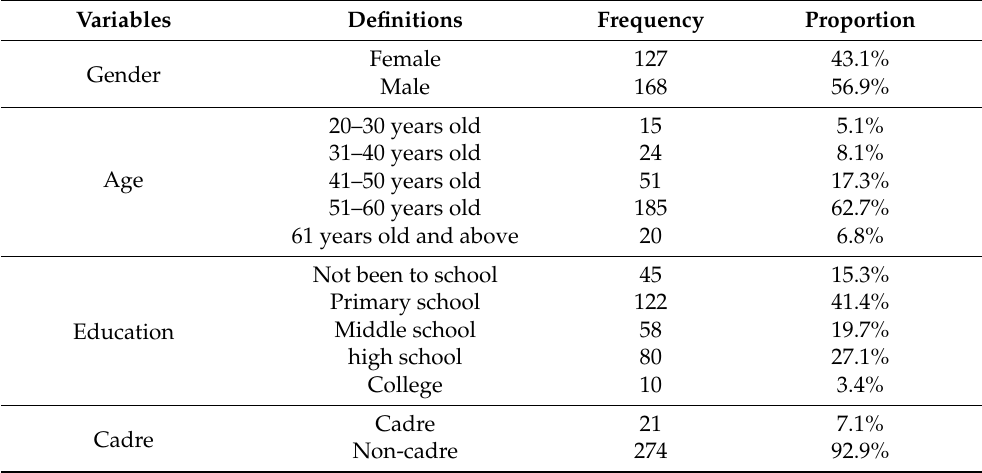
Table 1. Sample characteristics.